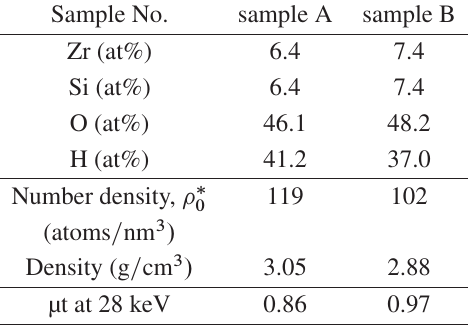
Table 1. ZrSiO 4 dried gels samples for high energy X-ray scattering